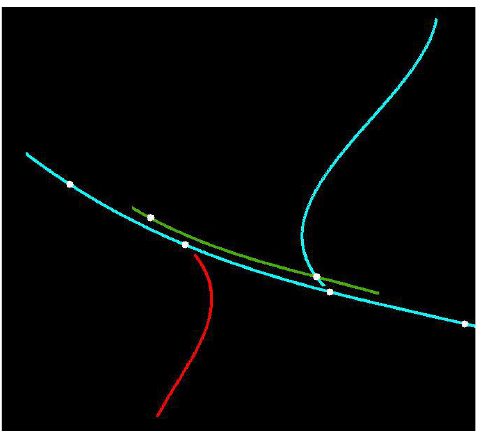
Figure 9. All the Potential Intersection Points